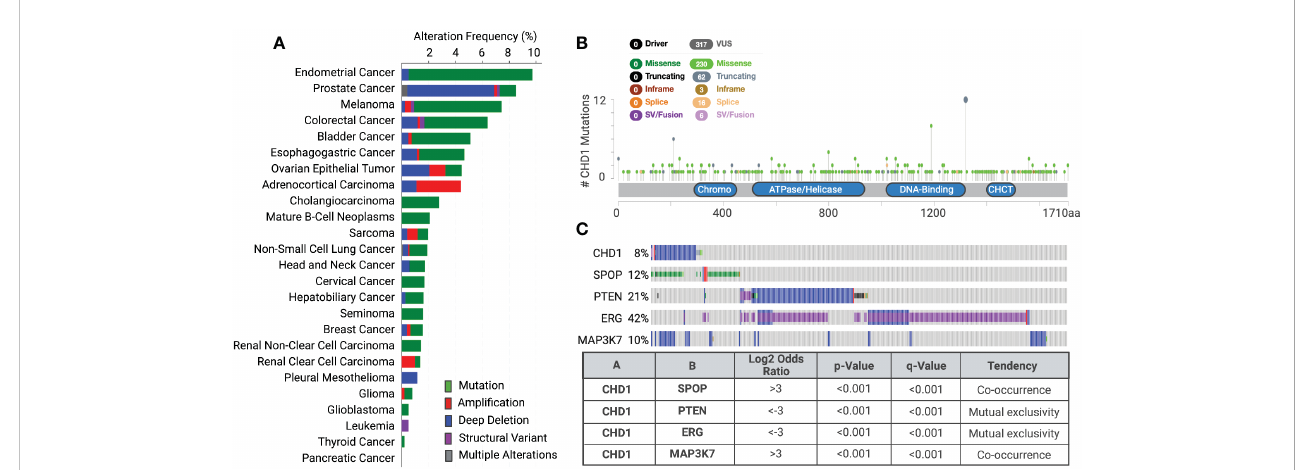
FIGURE 2 Genetic alterations of CHD1 cross various cancer types (A) Genetic alterations of CHD1 are frequent in human cancers (TCGA datasets). Different types of genetic alterations are highlighted in different colors. Their alteration frequency is presented in each cancer type. (B) Somatic mutations in CHD1 amino acid sequence across human cancers (TCGA databases). The number of single amino acid mutations is shown. Mutation diagram circles are colored with respect to the corresponding mutation types. The functional domains in the CHD1 protein are presented. (C) The co-occurrence and mutual exclusivity of CHD1 deletion and genetic alterations of SPOP, PTEN, ERG, and MAP3K7 in primary prostate tumors are shown (TCGA dataset). The Log2 Odds Ratio, p-value, q-value, and tendency between two genetic events are calculated